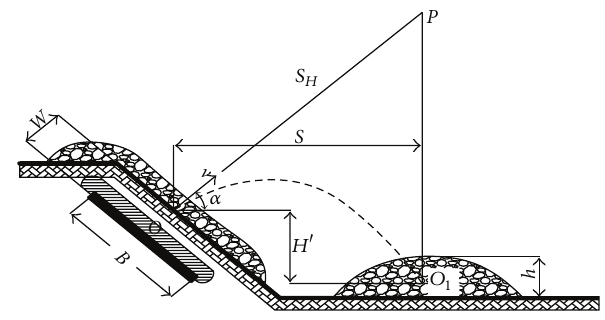
Figure 2: Effects of bench height on casting overburden.